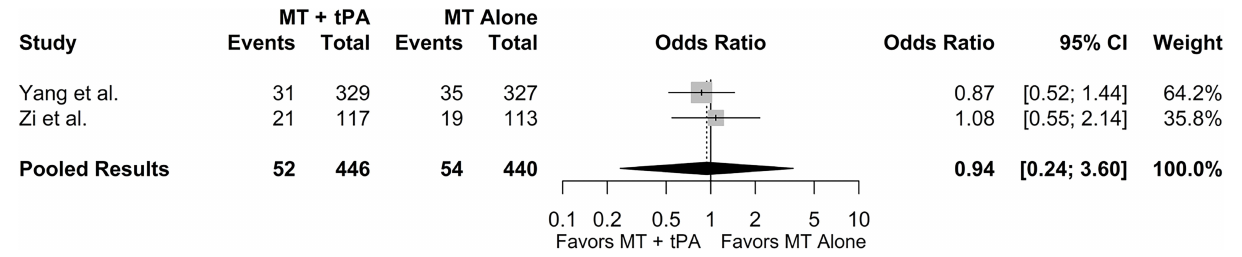
FIGURE 6 | Forest plot of comparisons of distal embolization to new territory. Pooled results were computed via the Mantel-Haenszel method, using restricted effects maximum likelihood for estimation of the between-study variance component and Hartung-Knapp adjustment to calculate a 95% confidence interval (CI) around the pooled effect